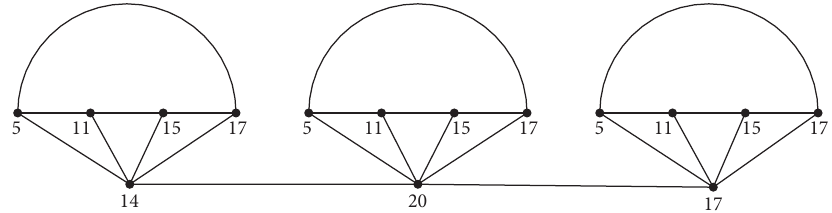
Figure 4: The graph G � P